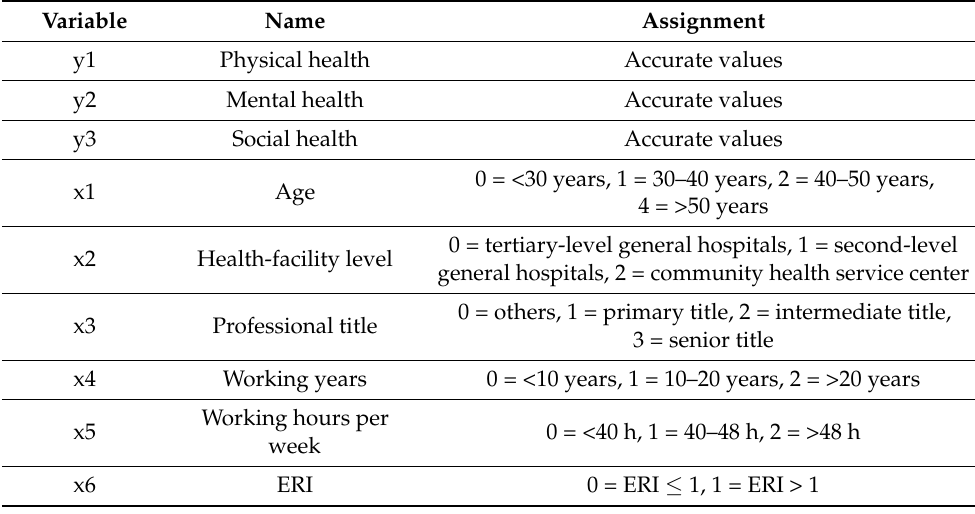
Table 5. Assignment of factor-specific